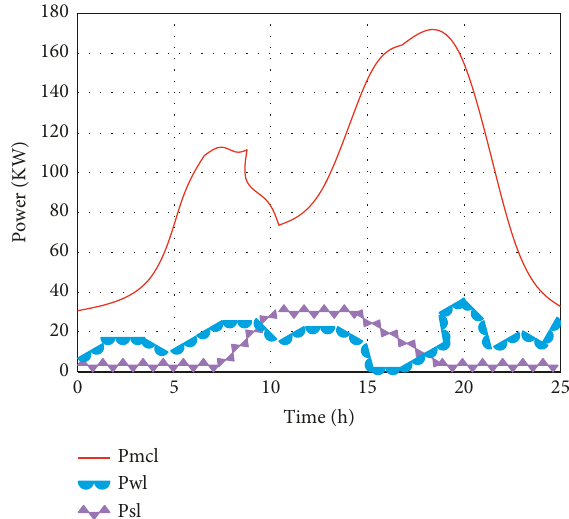
Figure 5: Wind and solar output and electrical load in one day.